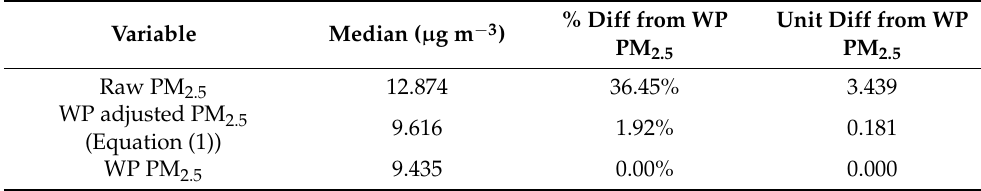
Table 2. Results from applying Equation (1) to PA